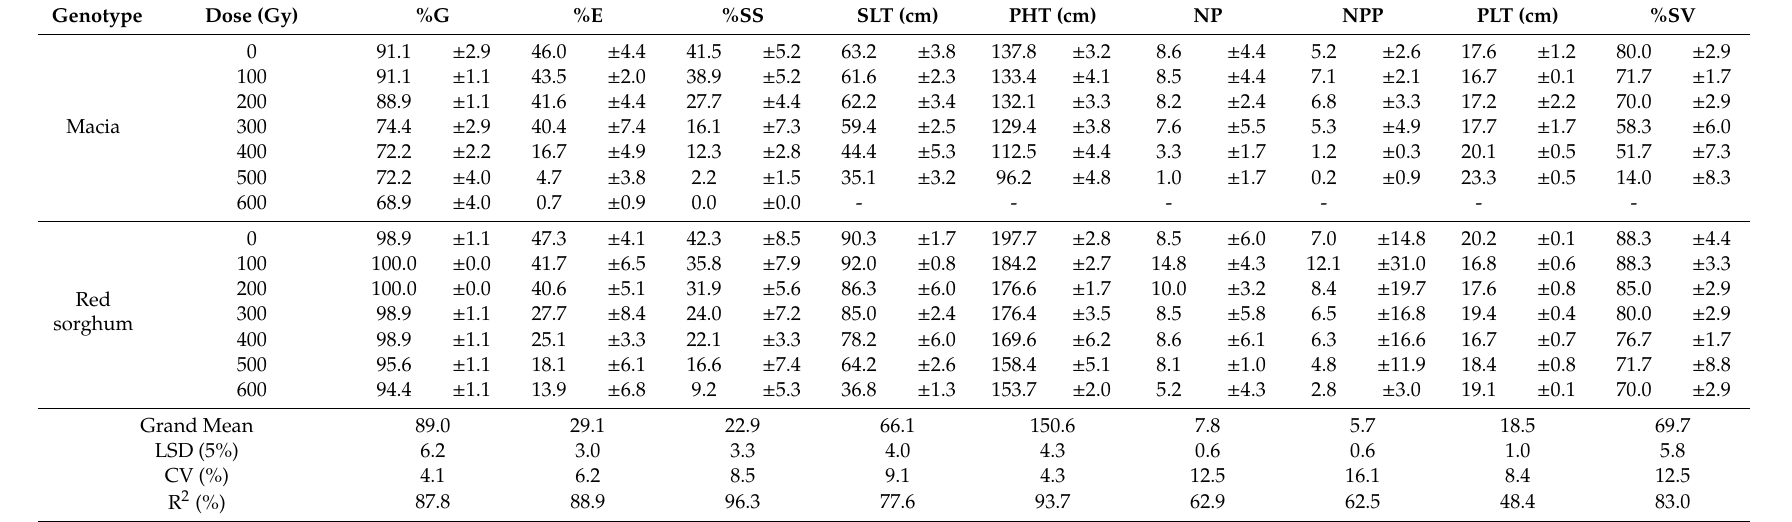
Table 4. Mean germination percentage (%G), emergence percentage (%E), seedling survival percentage (%SS), shoot length (SLT), plant height (PHT), number of panicles per m 2 (NP), number of productive panicles per m 2 (NPP), panicle length (PLT) and seed viability (%SV) of sorghum involving six gamma irradiations using three replications in experiment